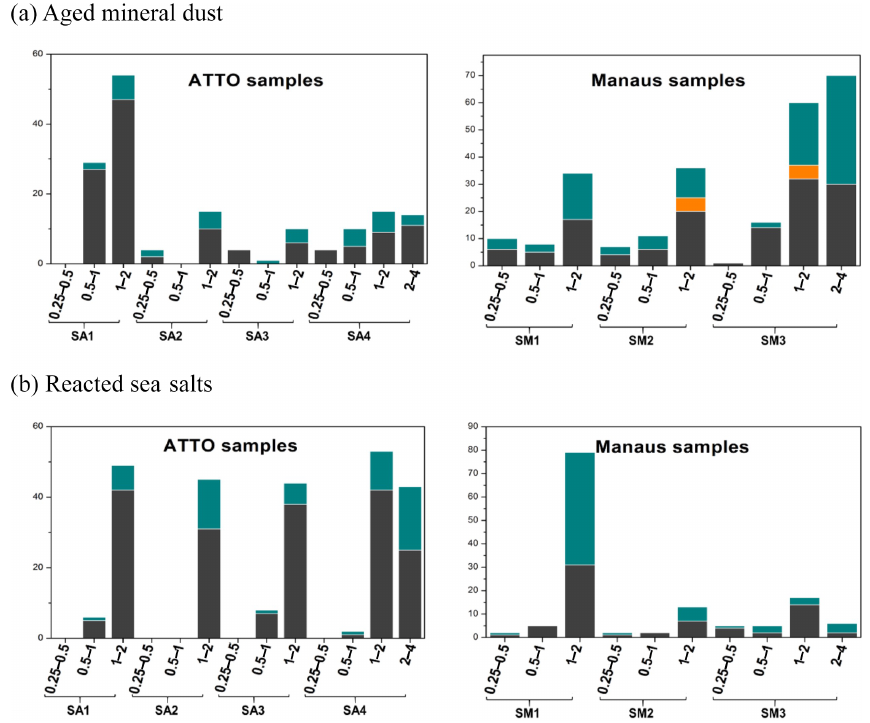
Figure 9. Number abundances of reacted sea-salt and aged mineral dust particles containing sulfates (black), nitrates (orange), and both (turquoise). The size ranges of each sample are given in the x